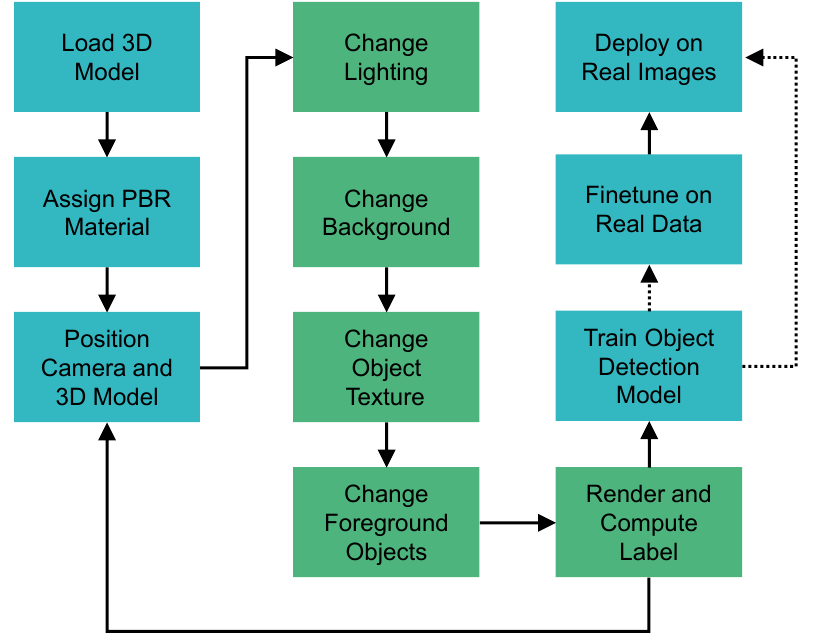
Figure 1. Our methodology for training an object detection model based on a 3D model as input. Different approaches for the green boxes are investigated in this